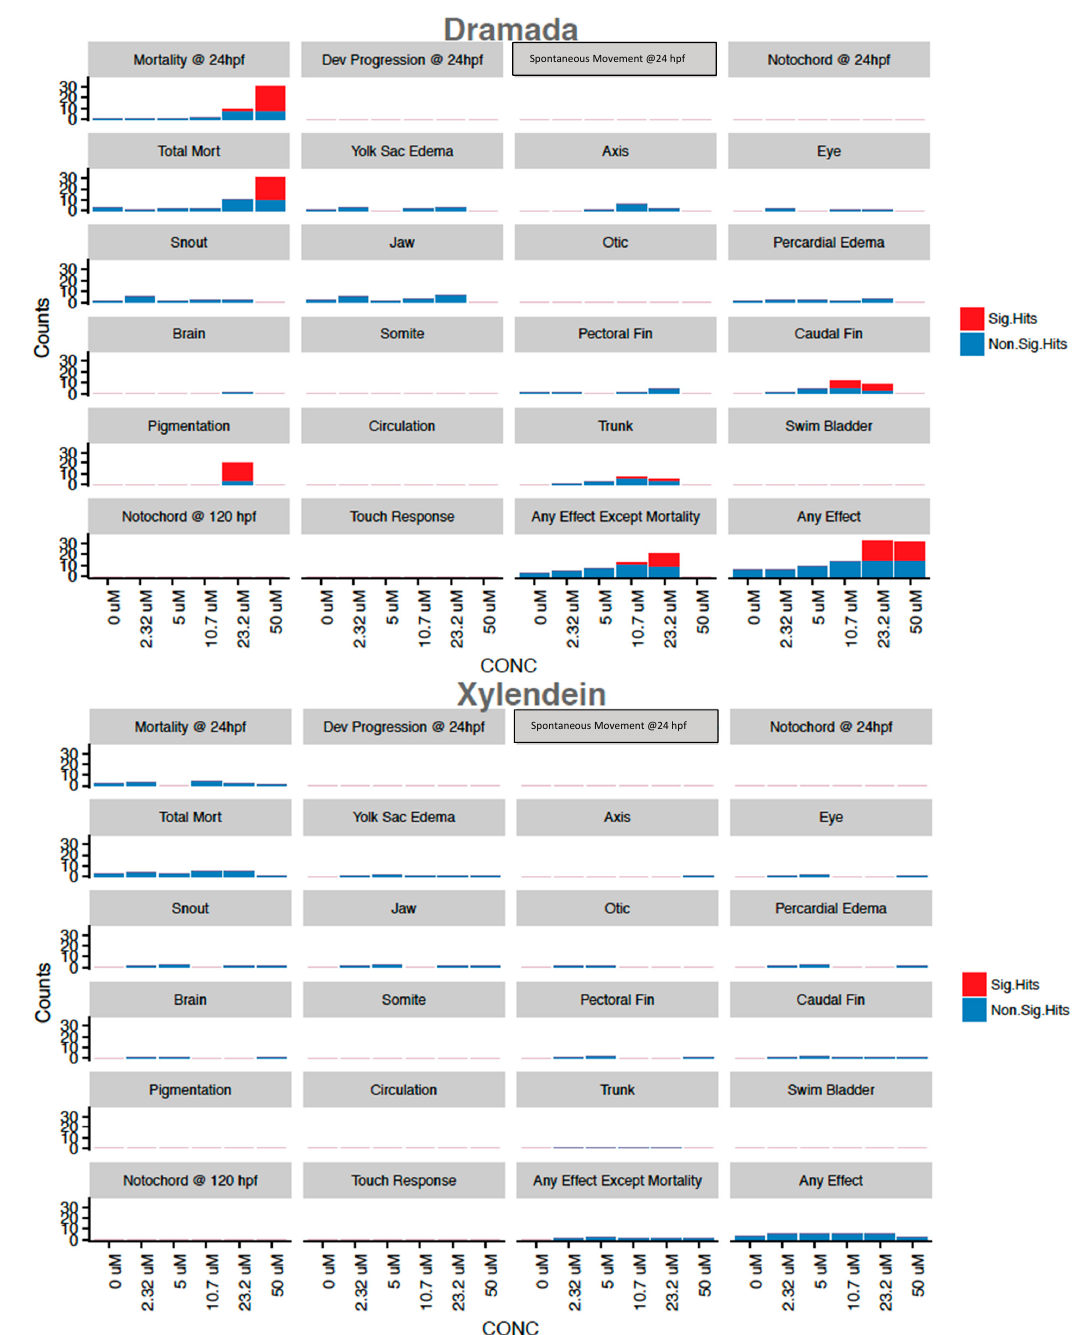
Figure 4. Mortality and Morphology Endpoint Counts for Dramada and Xylindein. Presence/absence data across 32 replicates with points above and at threshold for binomial significance in red. Concentration for xylindein is approximate due to lack of pure compound for testing. Control incidence of all morphological and touch response endpoints below 20% cutoff for biological